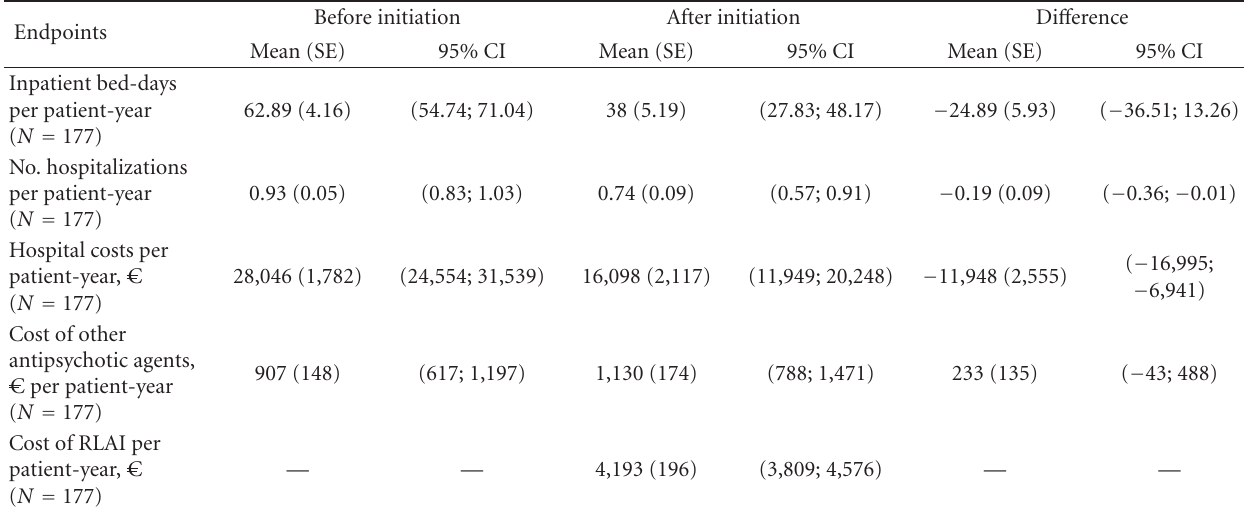
Table 5: Results of the main analysis. Hospitalisation episodes overlapping the date of RLAI initiation are allocated to the period before initiation. Sample unit ( N ) is the patient.